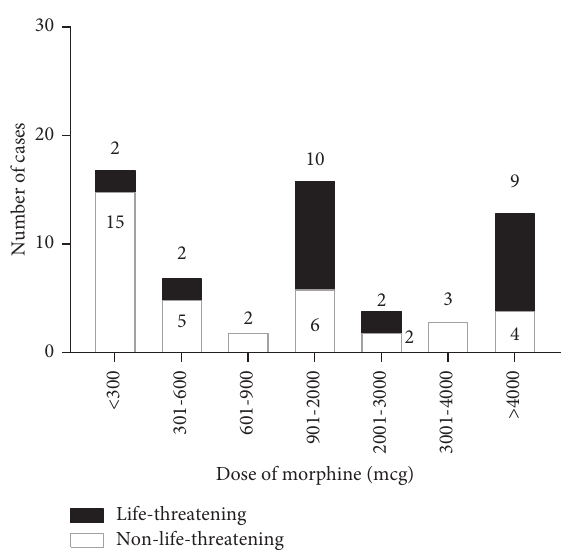
Figure 2: The number of reported cases with somnolence and/or respiratory depression, reported per range of intrathecal morphine